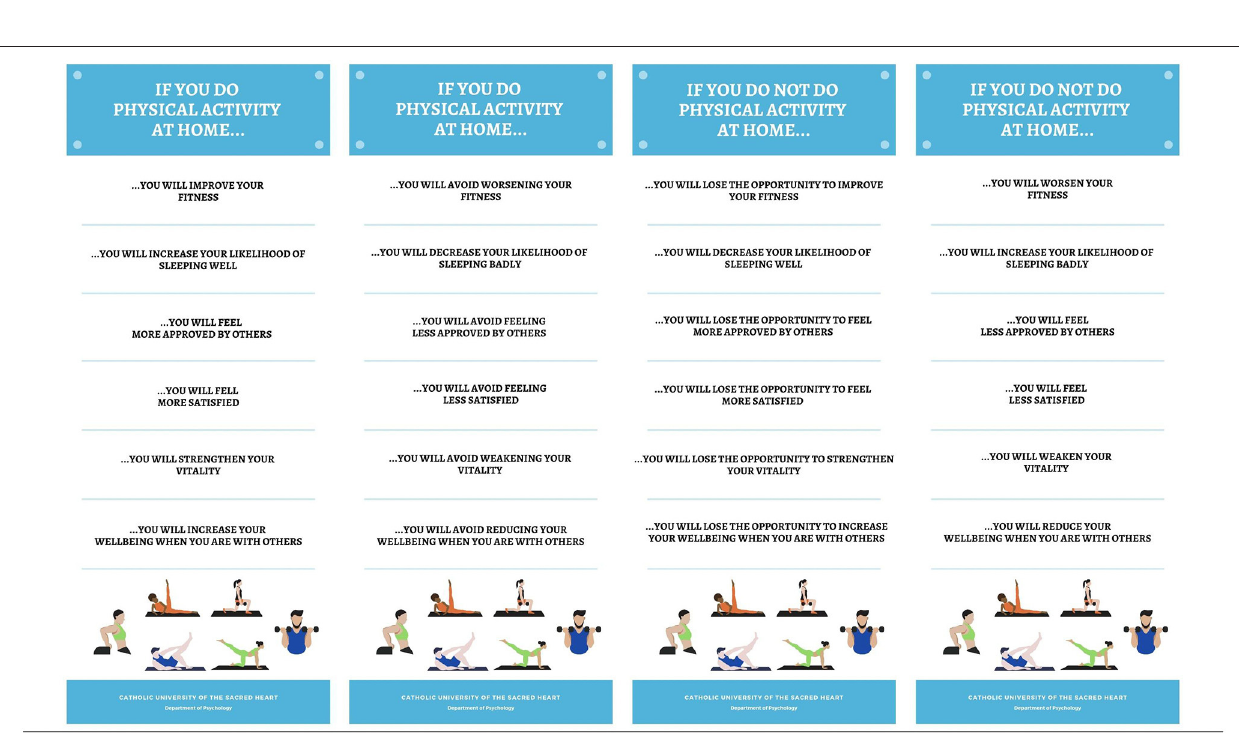
Frontiers in Psychology |